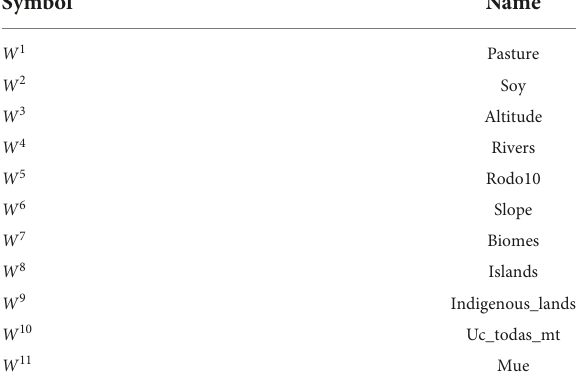
TABLE 2 Stationary features in the regression model (see Eq. 2).